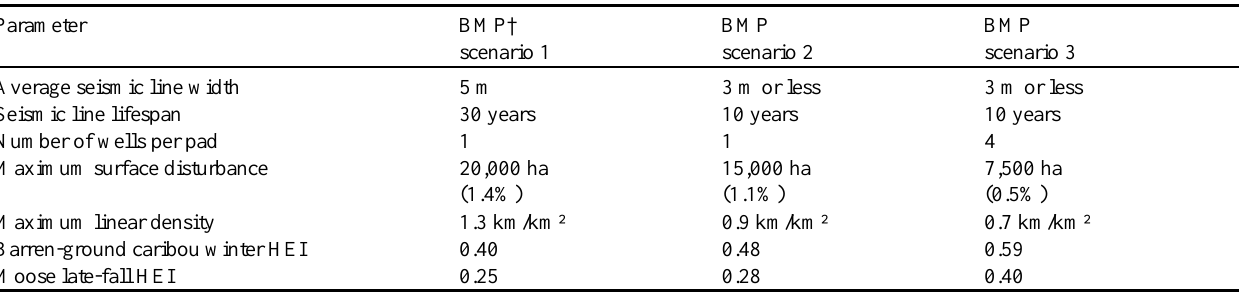
Table 5 . Comparison of different oil and gas operating practices (best management practice) scenarios and their relative effect on average barren-ground caribou winter Habitat Effectiveness Index (HEI) and average moose late-fall HEI at year 50 of simulation